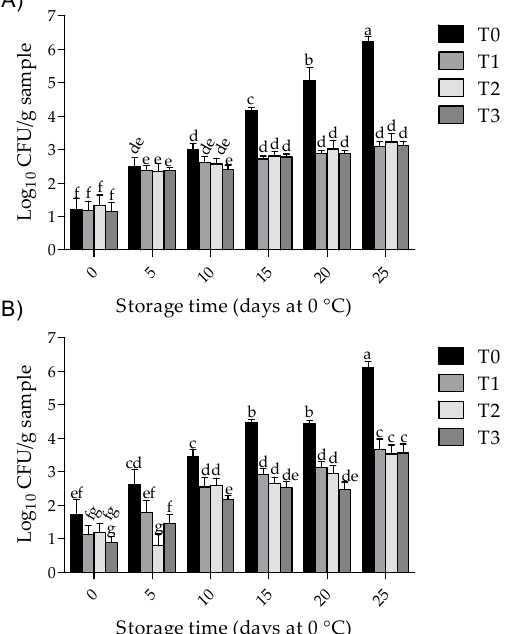
Figure 3. Effect of chitosan with GTWE and storage time on microbial growth of pork chop samples. Mesophilic ( A ) and psychrotrophic counts ( B ); values are expressed as mean ± standard deviation. T0 (non-coated chops and without antioxidant); T1 (chitosan-coated chops without antioxidant); T2 (chitosan-coated chops plus 0.1% of GTWE); and T3 (chitosan-coated chops plus 0.5% of GTWE). Different superscripts (a–f) indicate significant differences among treatment x storage time effects ( p < 0.05).